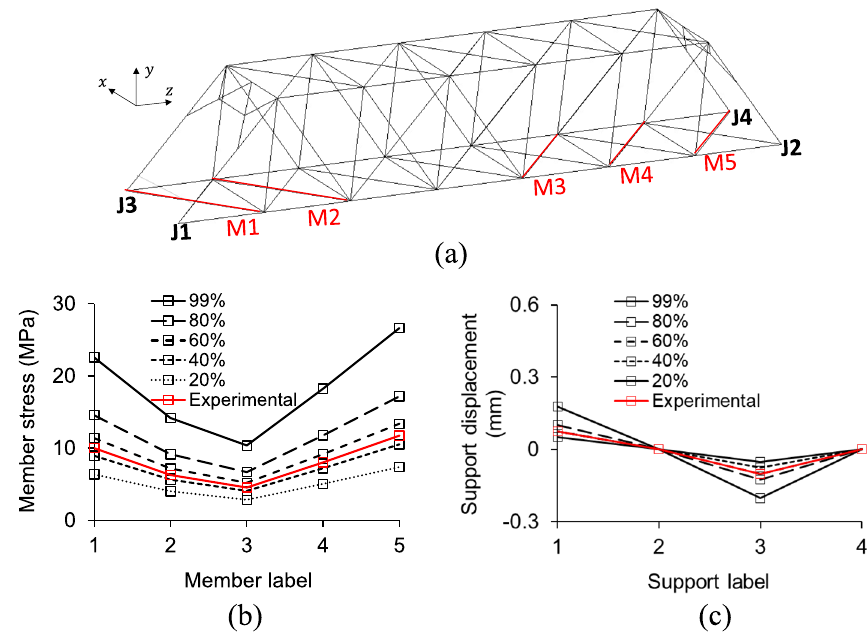
Fig. 11 Member response: a labeled joints and members; b member stress; c support displacement in the longitudinal